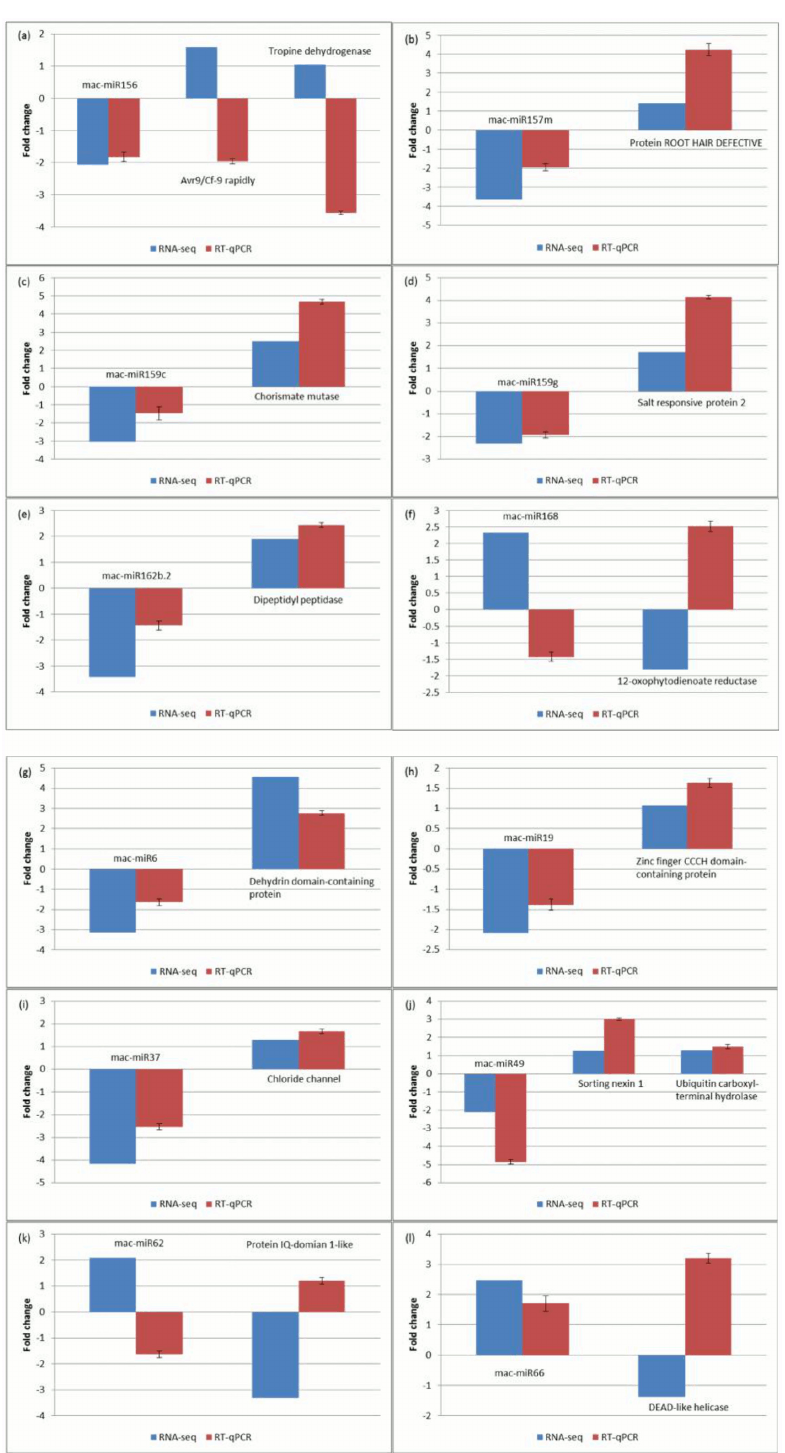
Fig 5. Real-time quantitative PCR analyses of selected miRNAs and their predicted target mRNAs in root tissues of banana plantlets grown under 300 mM NaCl treatment. MiRNA and their corresponding target mRNA are arranged to appear together in each graph (a)-(f) plant orthologous miRNA; (g)-(l) Musa - specific miRNA. Fold changes in gene expression shown are relative to the expression in the non-stressed roots (control). RNA-seq and PCR data are both shown in linear scale. Errors bars indicate mean ± standard deviations obtained from three biological